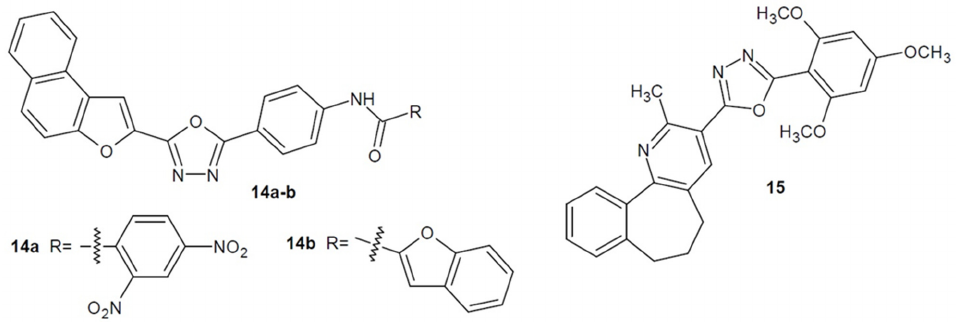
Figure 7. Aryl and/or heteroaryl 1,3,4-oxadiazole derivatives with antibacterial activity (part 3).